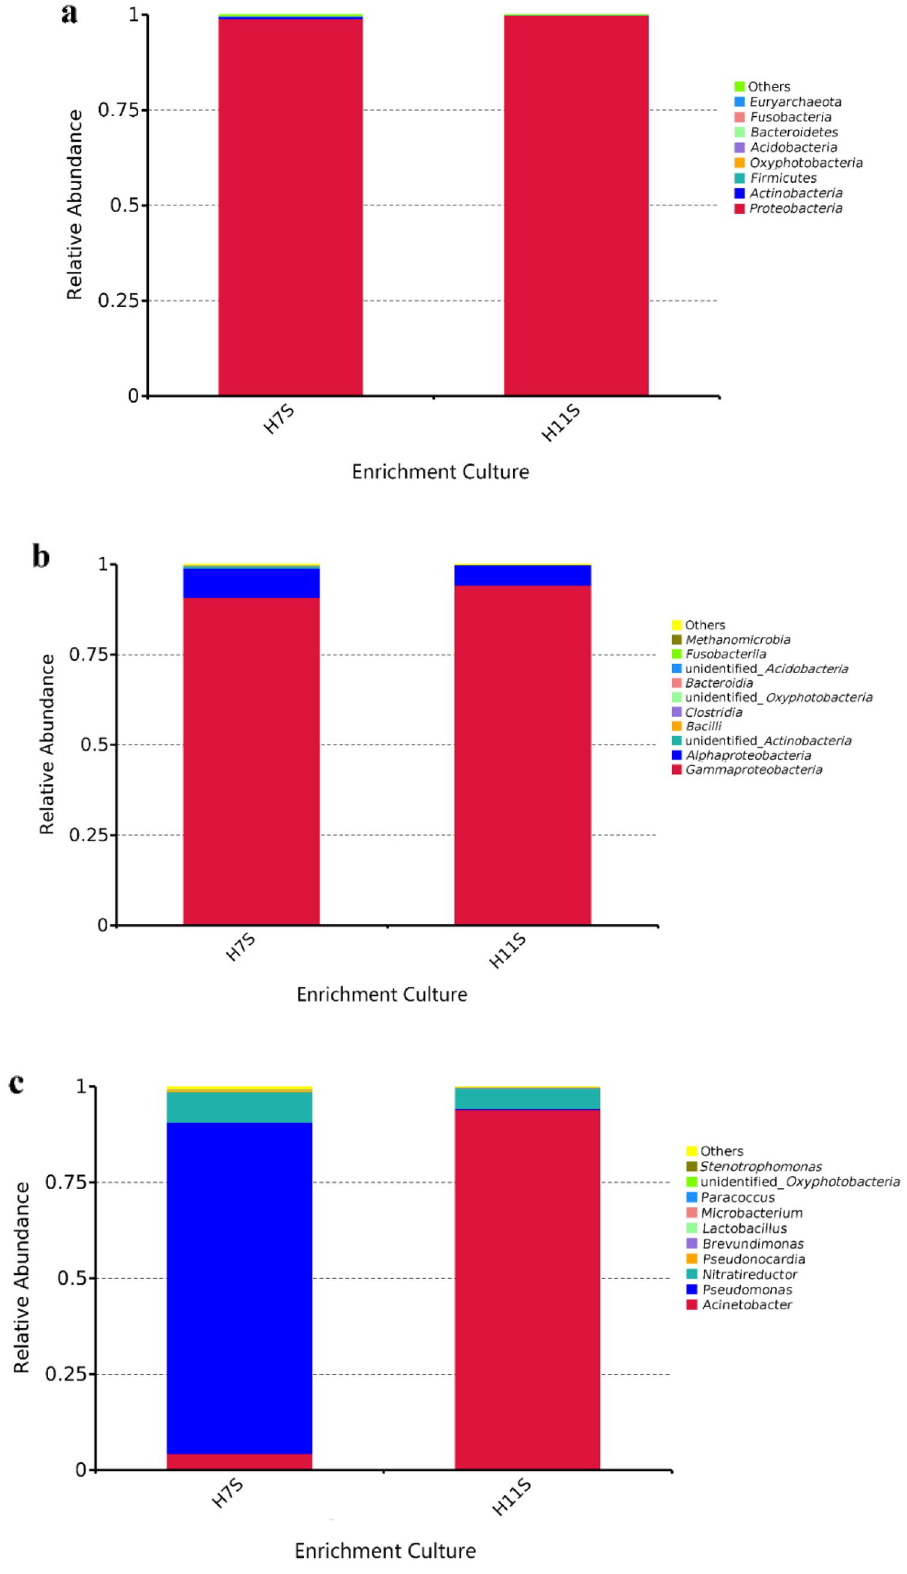
Figure 4. Bacterial community structure at different levels ( a phylum level. b class level. c genus